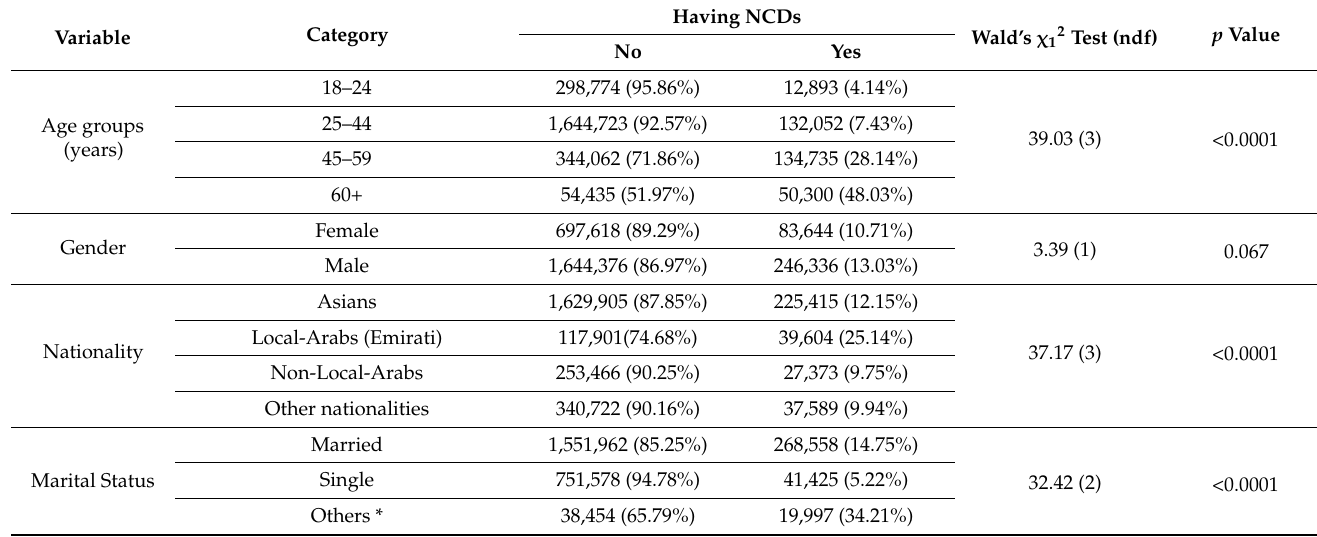
Figure 1. Distribution of Age by Gender, Nationality, Marital Status and Education Groups. Table 1. Sociodemographic characteristics of the Dubai population with self-reported non-communicable diseases from the DHHS